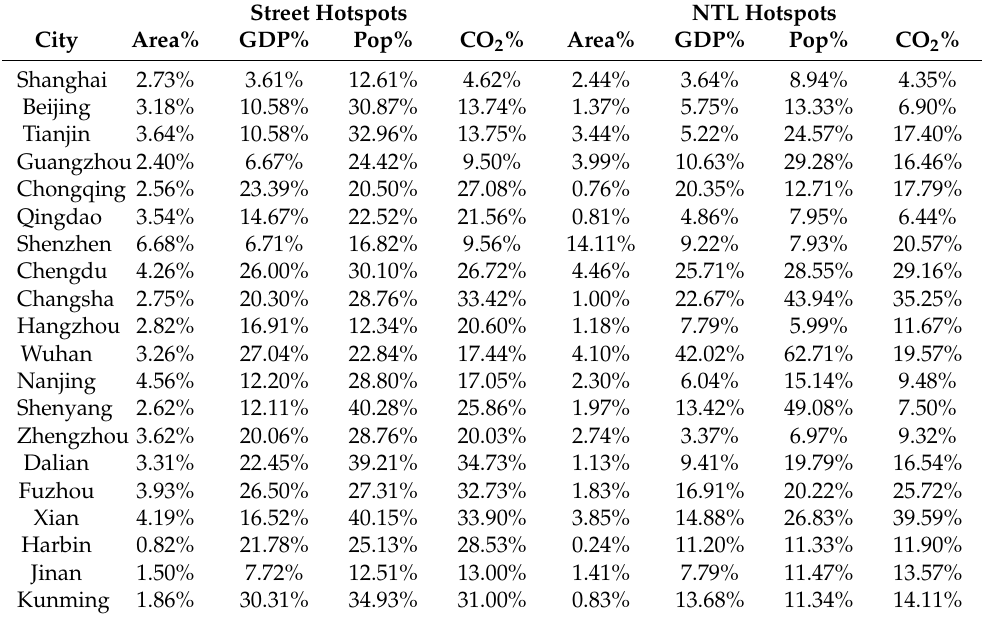
Table 4. Percentages of area, gross domestic product (GDP), population, and CO 2 emissions inside urban hotspots to those of the entire city. (Note: Pop: Population; CO 2 : CO 2 emissions). Street Hotspots NTL Hotspots City Area%